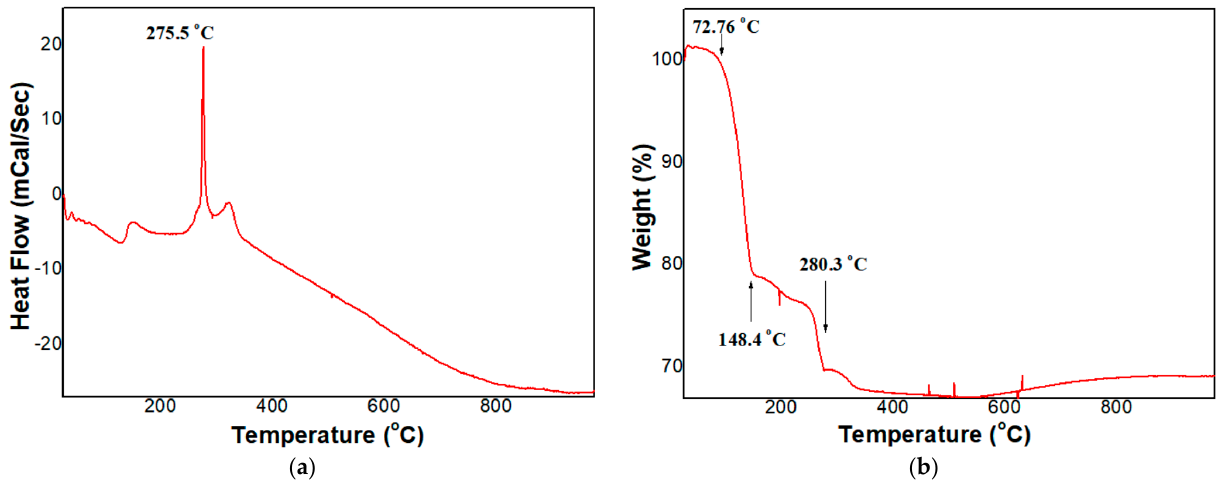
Figure 2. ( a ) Differential thermal analysis and ( b ) Thermogravimetric analysis of Sn(II) acetate.